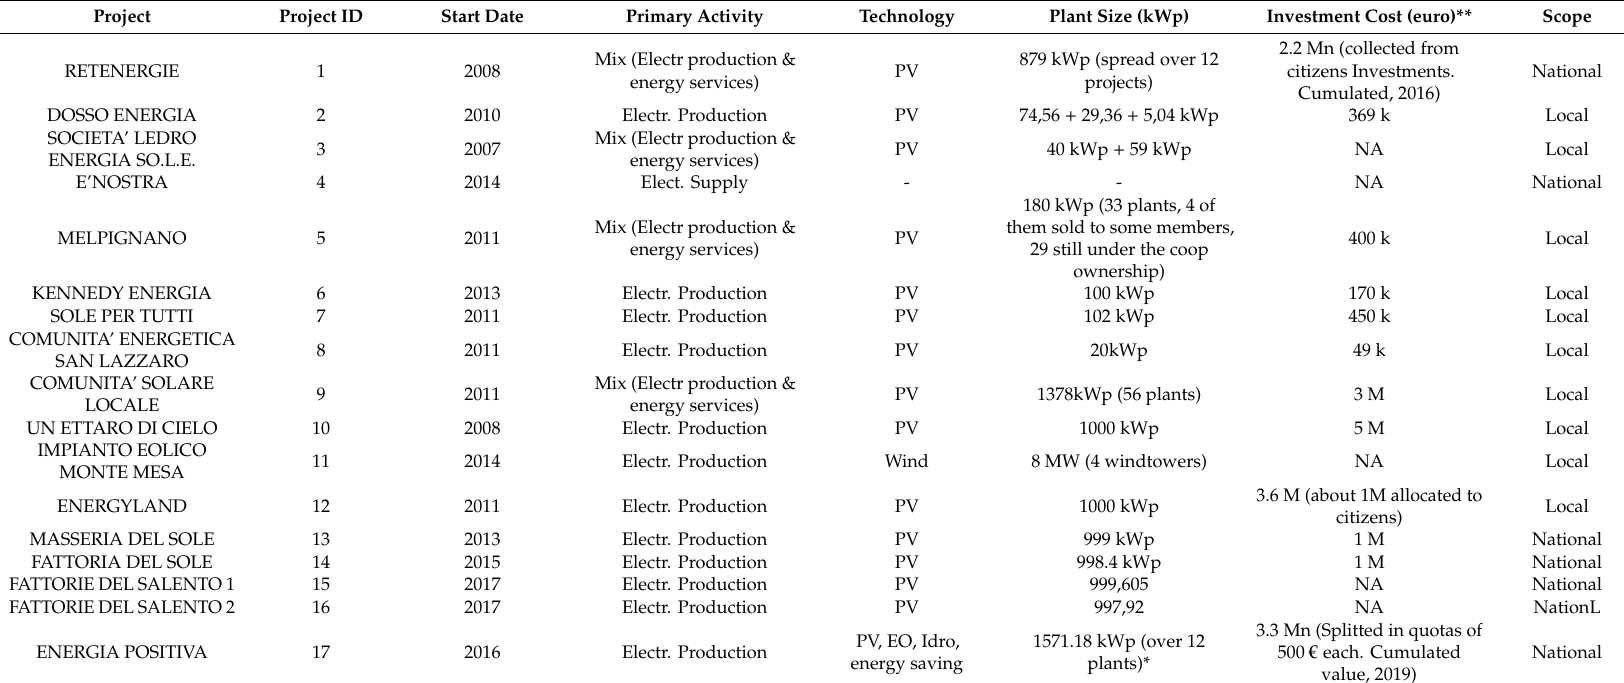
Table A2. Type of activity and